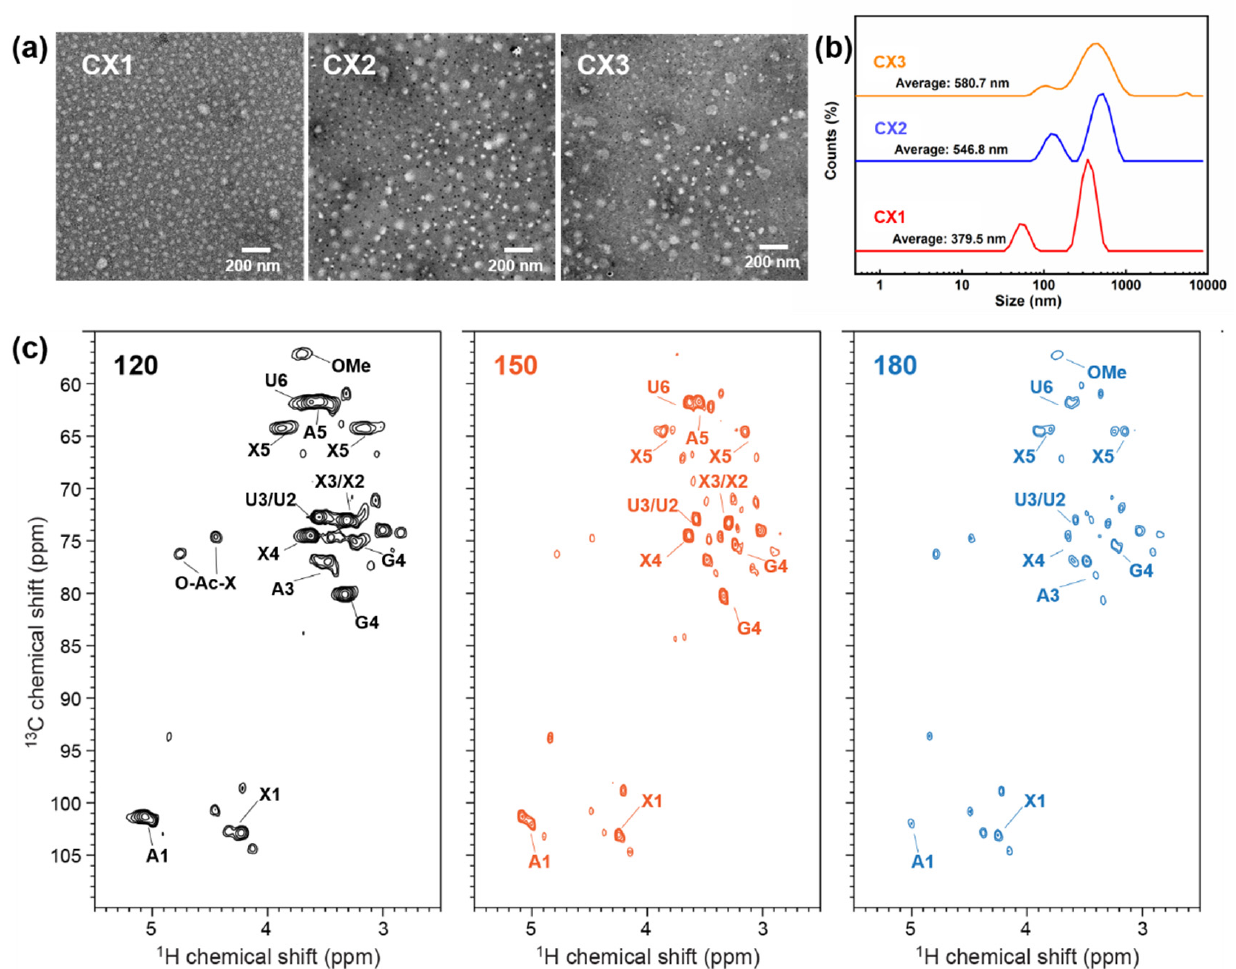
Figure 4. TEM images ( a ) and DLS results ( b ) of the hydrolyzates after HTP; 2D HSQC NMR spectra of hemicelluloses fractions ( c ).